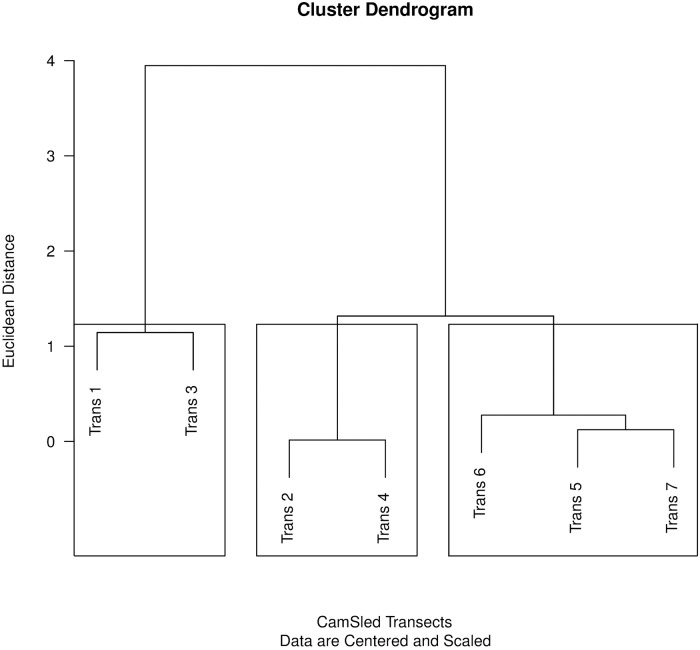
Dendrogram showing the distribution of species from the camera sled counts.Counts were centered and scaled before analysis. Three clusters were identified based on organism class identification. The cluster containing Transects 5−7 was the most completely sampled, but also had lower diversity.